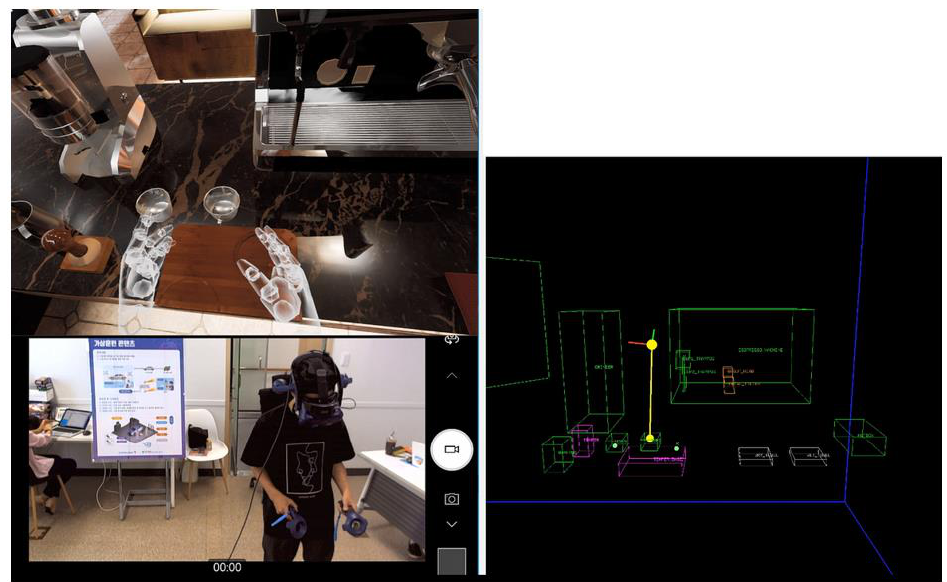
Figure 7. A screenshot of the video data displaying the virtual space, subject’s behavior, and eye - tracking data simultaneously.